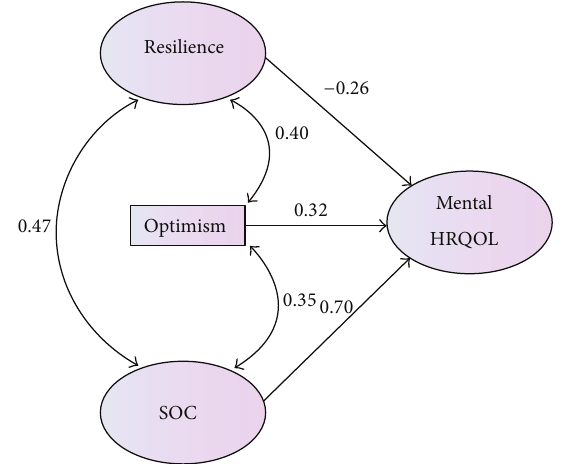
Figure 1: Note . SOC = sense of coherence; HRQOL = health related quality of life.